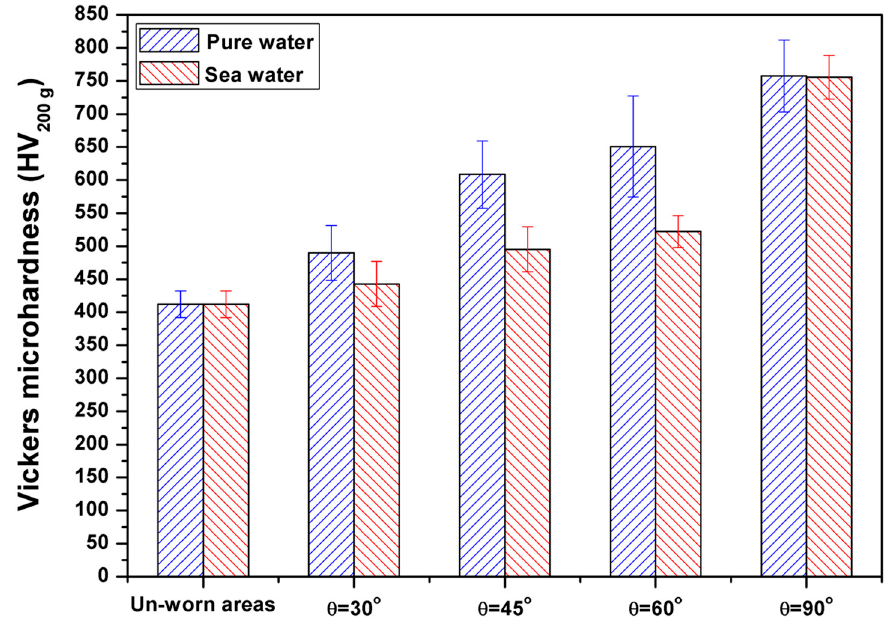
Figure 12. Microhardness values of worn and unworn SLMed Ti-6Al-4V alloy. The worn areas are the result of slurry erosion in pure water and seawater at impact angles of 30°, 45°, 60°, and 90°. The slurry erosion test at a normal impact angle is similar to the wet shot peening process. For both of these tests, the specimens are impacted in the vertical direction with high-speed solid